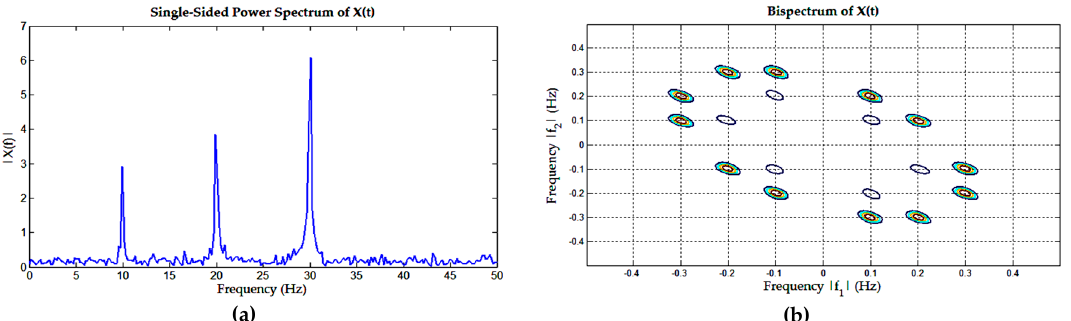
Figure 2. Comparison between ( a ) power spectrum which shows dominant frequencies and ( b ) bispectrum, which shows dominant frequencies and their correlation (if